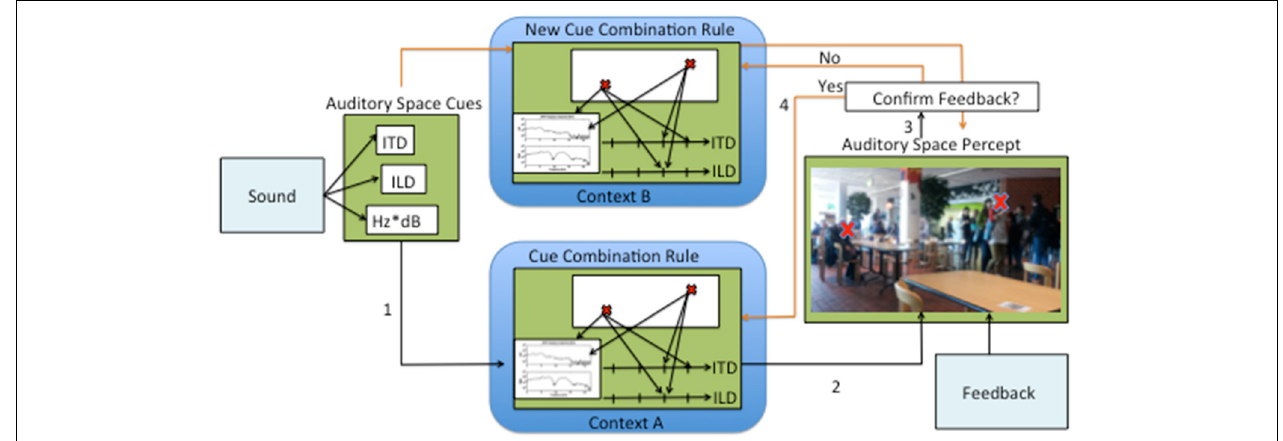
FIGURE 1 | Illustration of a hypothetical process of auditory adaptation through continuous sensory experience. First the input sound is decomposed into auditory space cues, then (1) a correspondence is established between the cues and a point in perceptual space. After a correspondence is established (2) a percept is formed. Perceiving auditory